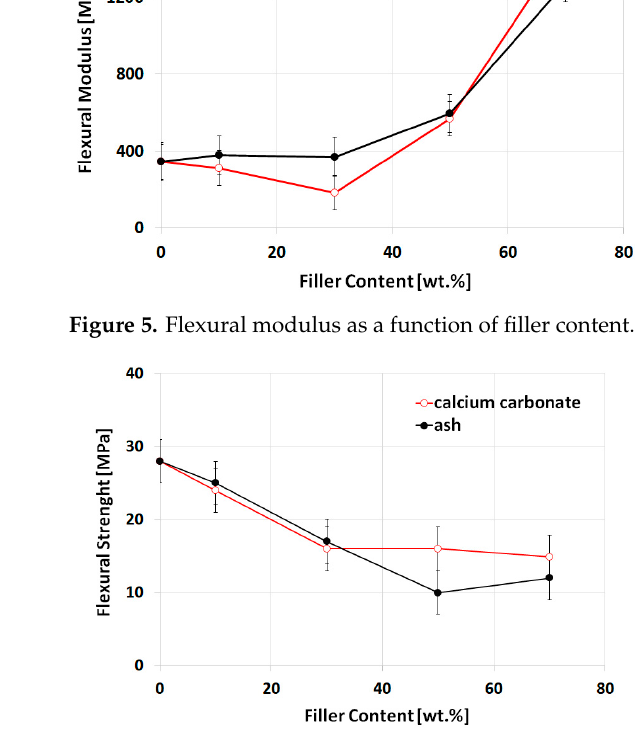
Figure 6. Flexural strength as a function of filler content.